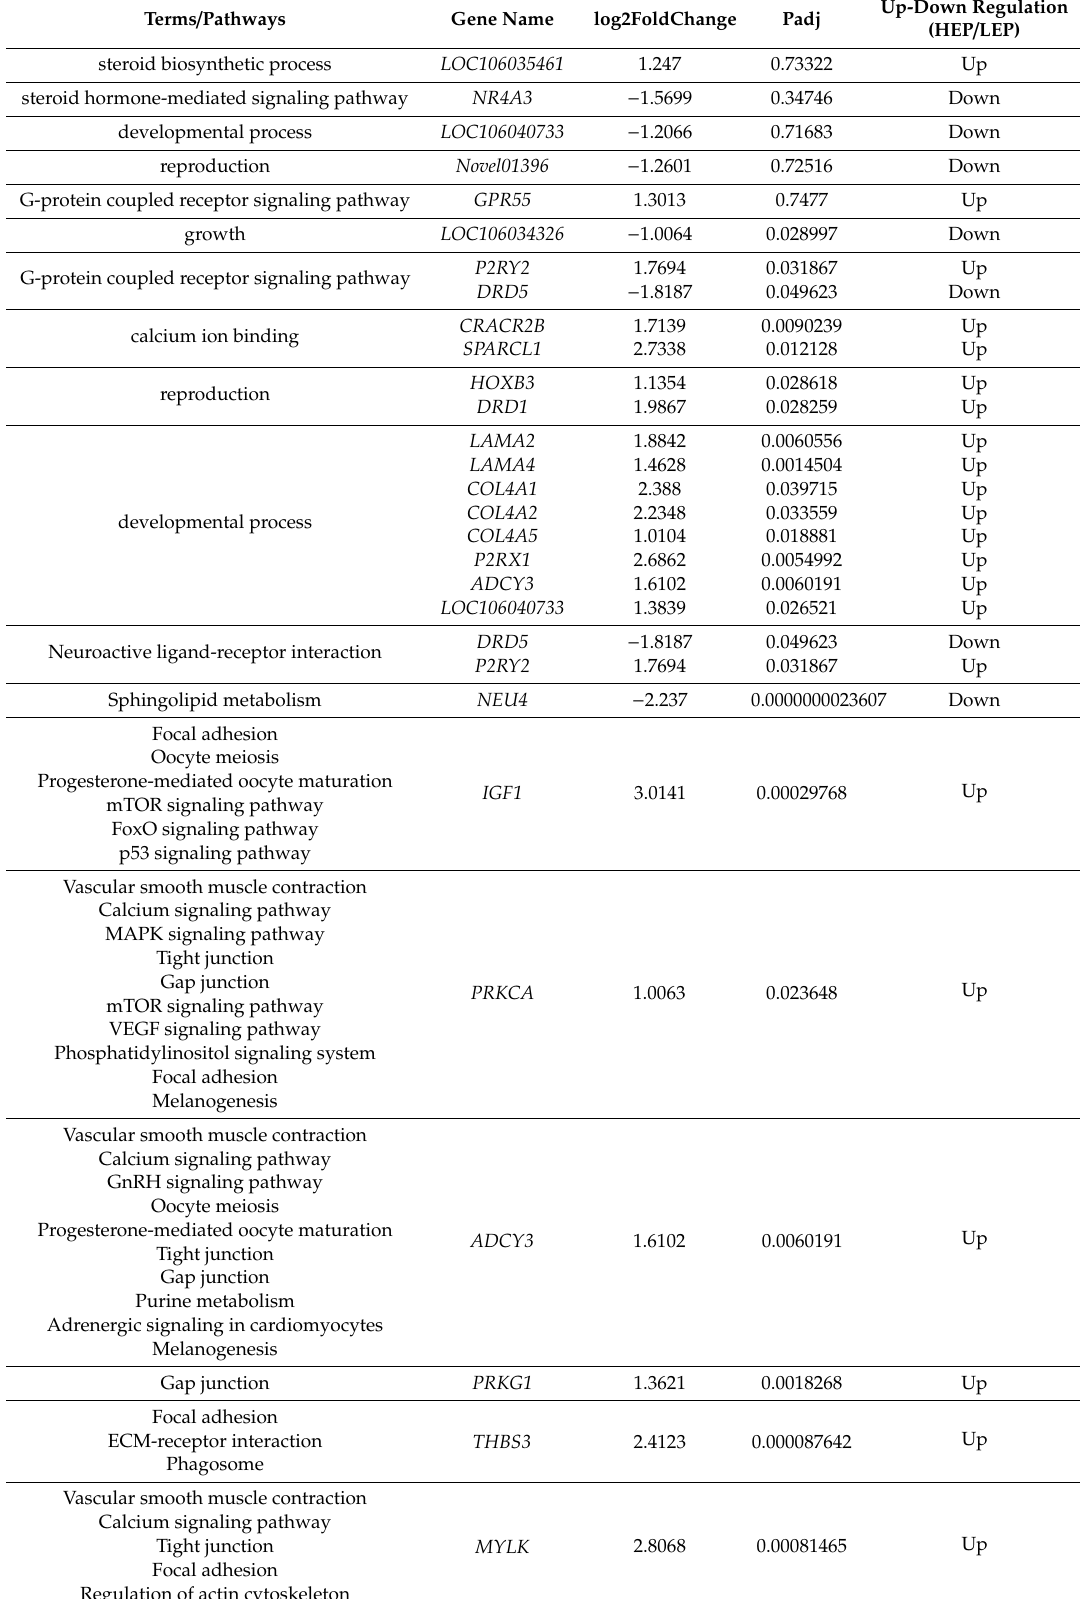
Table 3. Putative candidate genes of the DEGs associated with geese